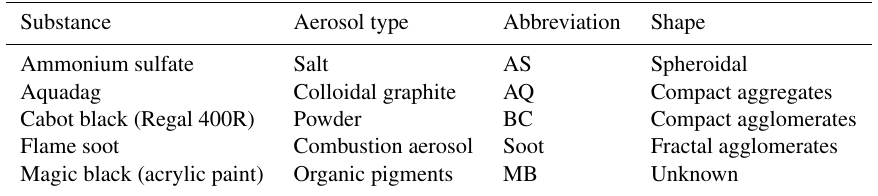
Table 1. Overview of aerosol types used. Substance